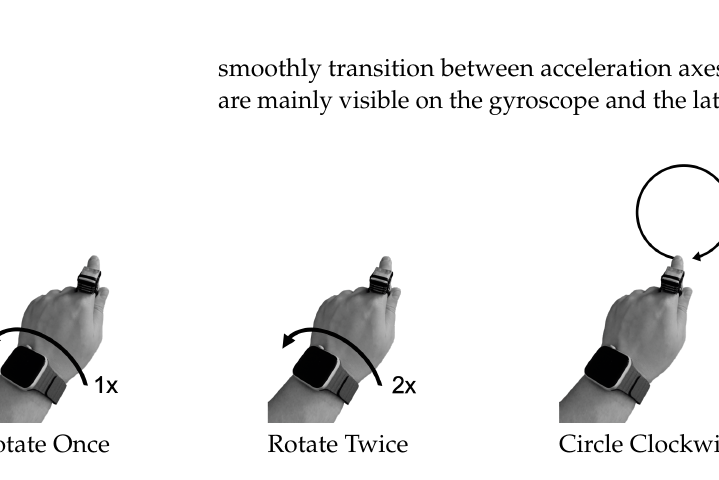
Figure 6. Gestures based on rotation information around the X-axis or inside the YZ-plane.